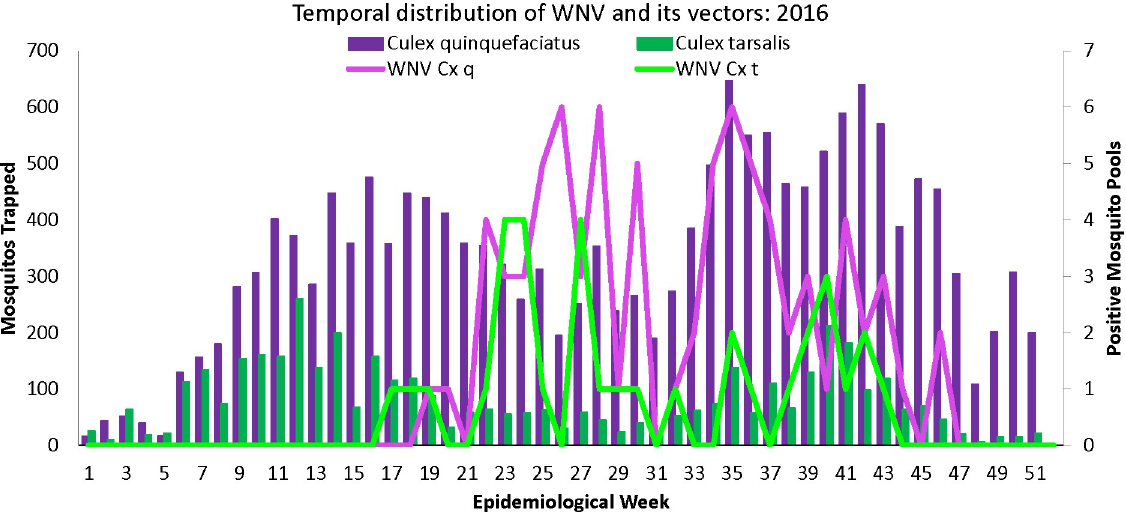
Fig 4. Distribution of Culex mosquitoes and WNV positive pools in Maricopa County by epidemiological week in 2016. The first y-axis represents the number of Culex quinquefasciatus (purple bars) and Culex tarsalis (green bars) individuals trapped each epidemiological week. The second y-axis represents the number of WNV positive Culex quinquefasciatus (purple line) and WNV positive Culex tarsalis (green line) mosquito pools trapped each epidemiological week.